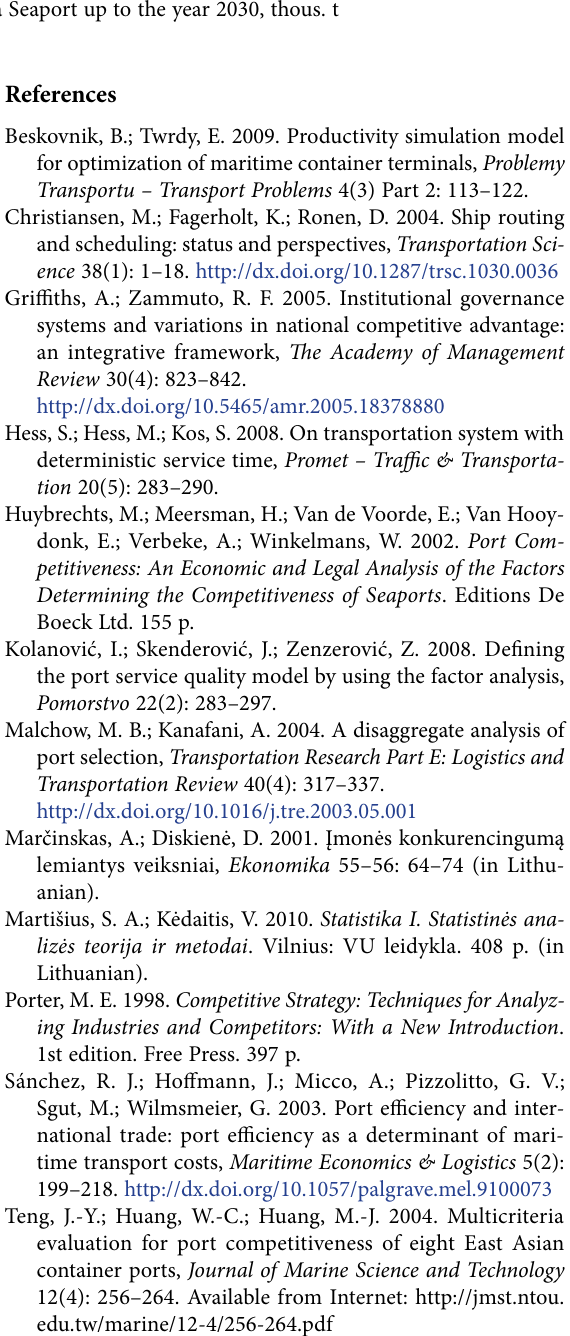
Fig. 2. Forecast of cargo flows of Klaipėda Seaport up to the year 2030, thous.